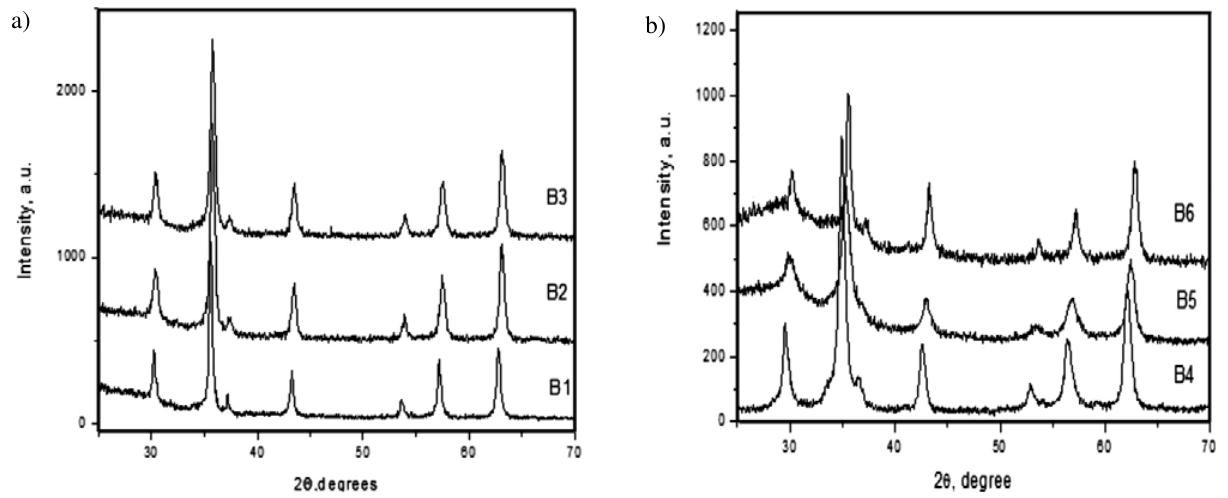
Figure 1. XRD patterns of the samples, from bottom to top (a) ZC31/4, ZC11/4, ZC13/4 and (b) ZC31/8, ZC11/8, ZC13/8,